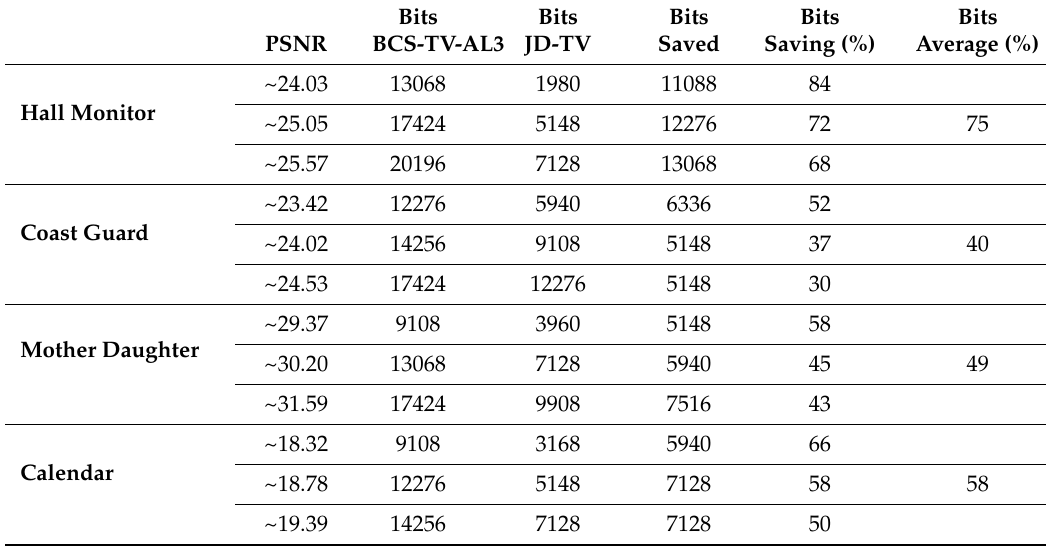
Table 8. Analysis of the proposed JD and BCS-TV-AL3 scheme in terms of bits saved at various reconstruction qualities